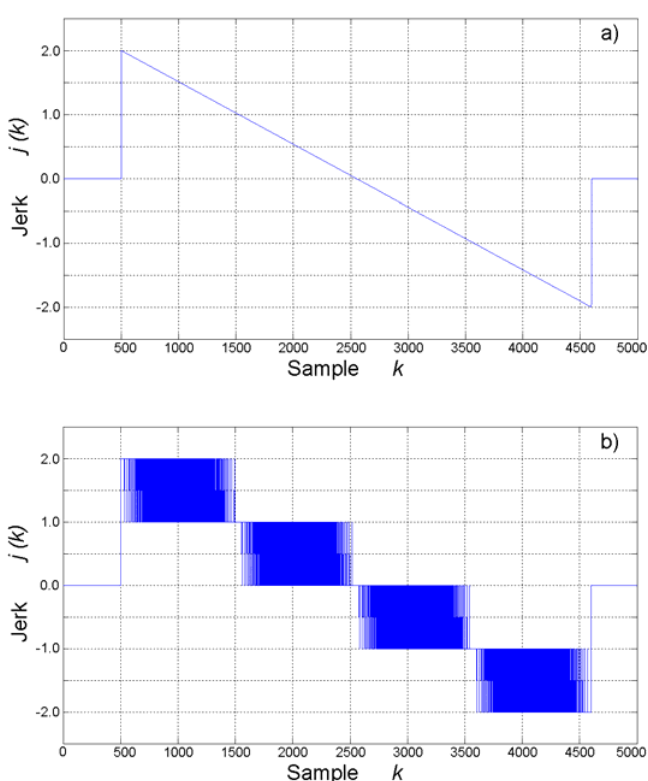
Figure 7. Jerk estimation. (a) Theoretical. (b) Nyquist rate. (c) 4-times oversampling. (d) 8-times oversampling. (e) 16-times oversampling. (f) 32-times